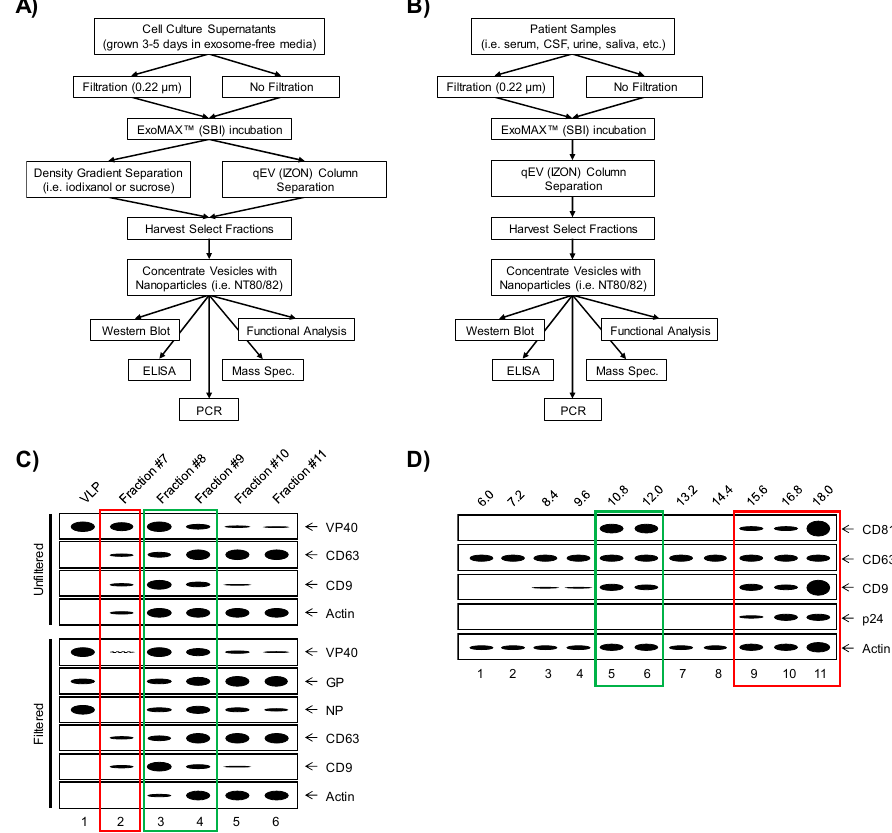
Figure 1. Separation of extracellular vesicles (EVs) from virus for downstream analysis. An optimized workflow for the separation of EVs away from virus from a variety of backgrounds, including from cell culture supernatants ( A ) and patient samples ( B ). Expected profiles of Ebola virus (EBOV) vs. exosomal proteins when extracellular components (i.e., EV-containing cell culture supernatants or biofluids) are separated by size with qEV (IZON) columns, as outlined in the panel A workflow ( C ). Positive control virus-like particle (VLP) (containing VP40, nucleoprotein (NP) and GP) profiles are shown in lane 1, whereas a typical profile of EV-containing fractions of supernatants that were either unfiltered (top panel) or filtered through 0.22 µ m (bottom panel) from cells expressing VP40, NP and GP, followed by separation on qEV size exclusion columns are shown. Expected profiles of mature human immunodeficiency virus (HIV) virions (as indicated by p24 capsid protein) vs. exosomal marker proteins when cell culture supernatants are separated by density, such as by iodixanol or sucrose gradients, as outlined in the panel A workflow ( D ). Profiles demonstrated here are the expected results for iodixanol fractions in increments of 1.2% from 6.0%–18.0%. Fractions where either virions or VLPs are known to elute or sediment are indicated by red boxes. Fractions containing only exosomes and no viral particles are enclosed by green